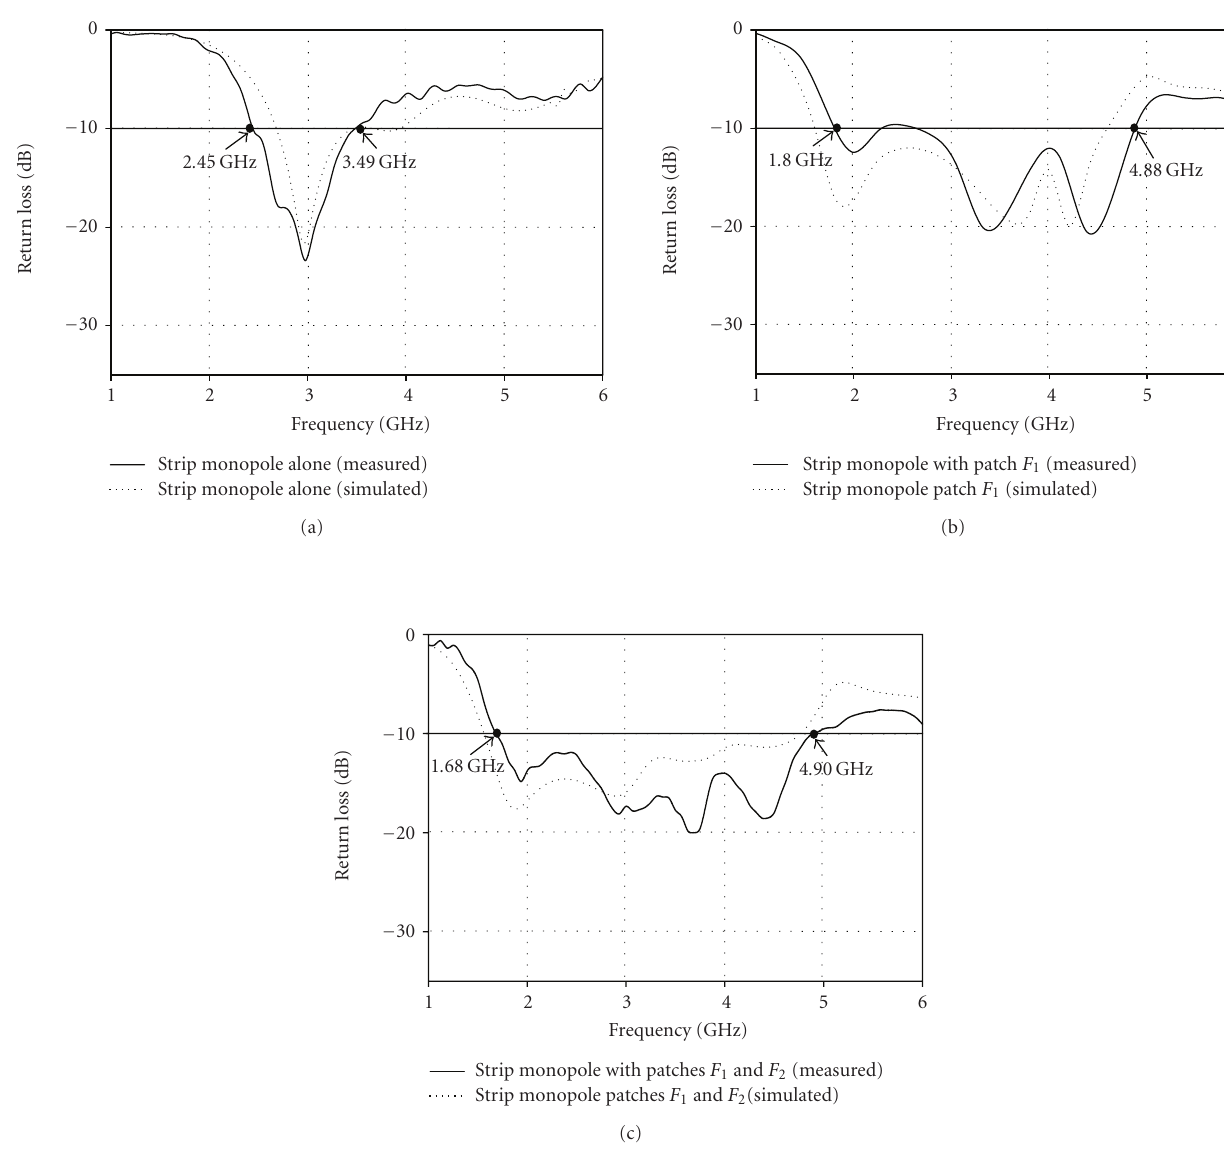
Figure 6: Measured and simulated return loss characteristics of the proposed antenna: (a) strip monopole alone [ L = 67, W G = 67, L G = 29, W h = 1 . 6 (units in mm), ε L M = 15, M = 3, (units in mm)], (c) Strip monopole with patches F 1 and F 2 [ S H 2 = 3, S L 2 = 5 . 25 (units in